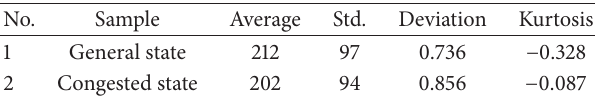
Table 5: Results of statistical analysis on the blink duration. No.